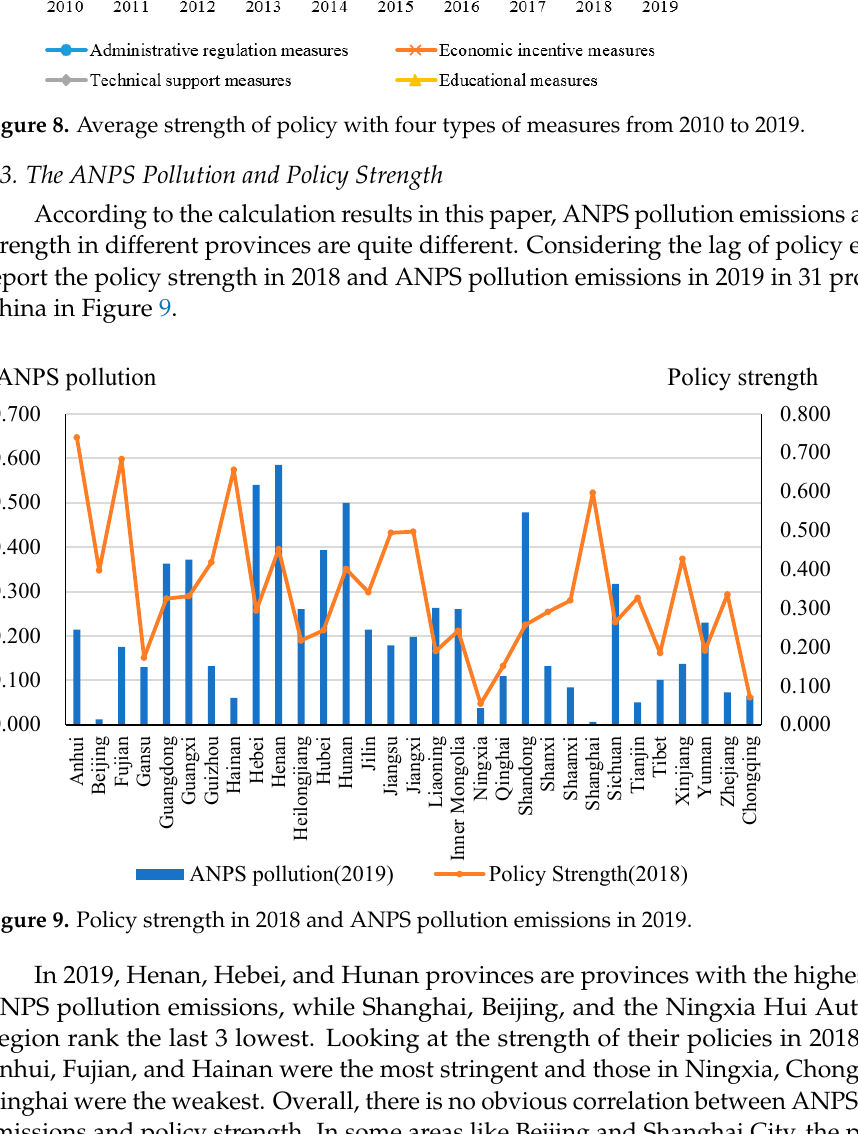
Figure 8. Average strength of policy with four types of measures from 2010 to 2019.